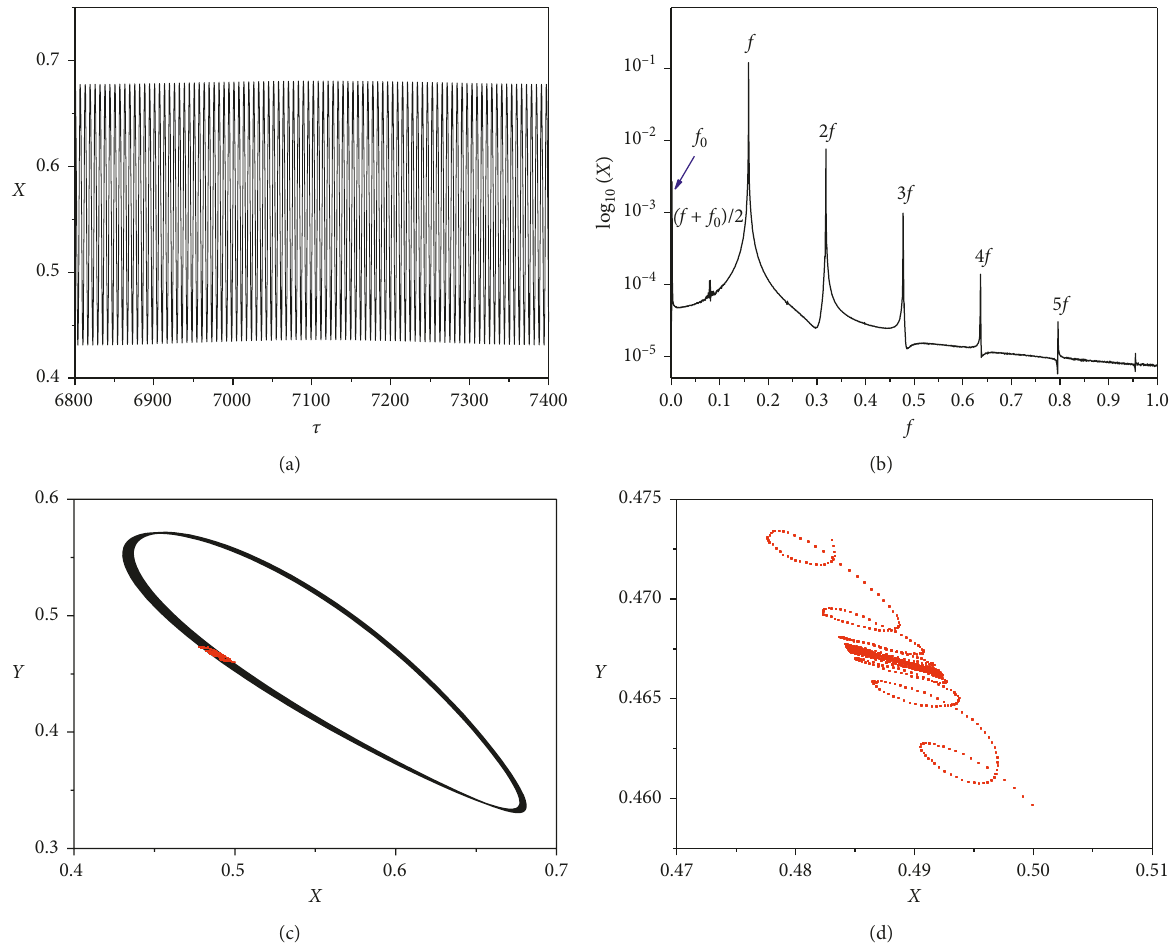
Figure 15: (a) Displacement. (b) Frequency response. (c) Rotor orbit. (d) Poincar´e map